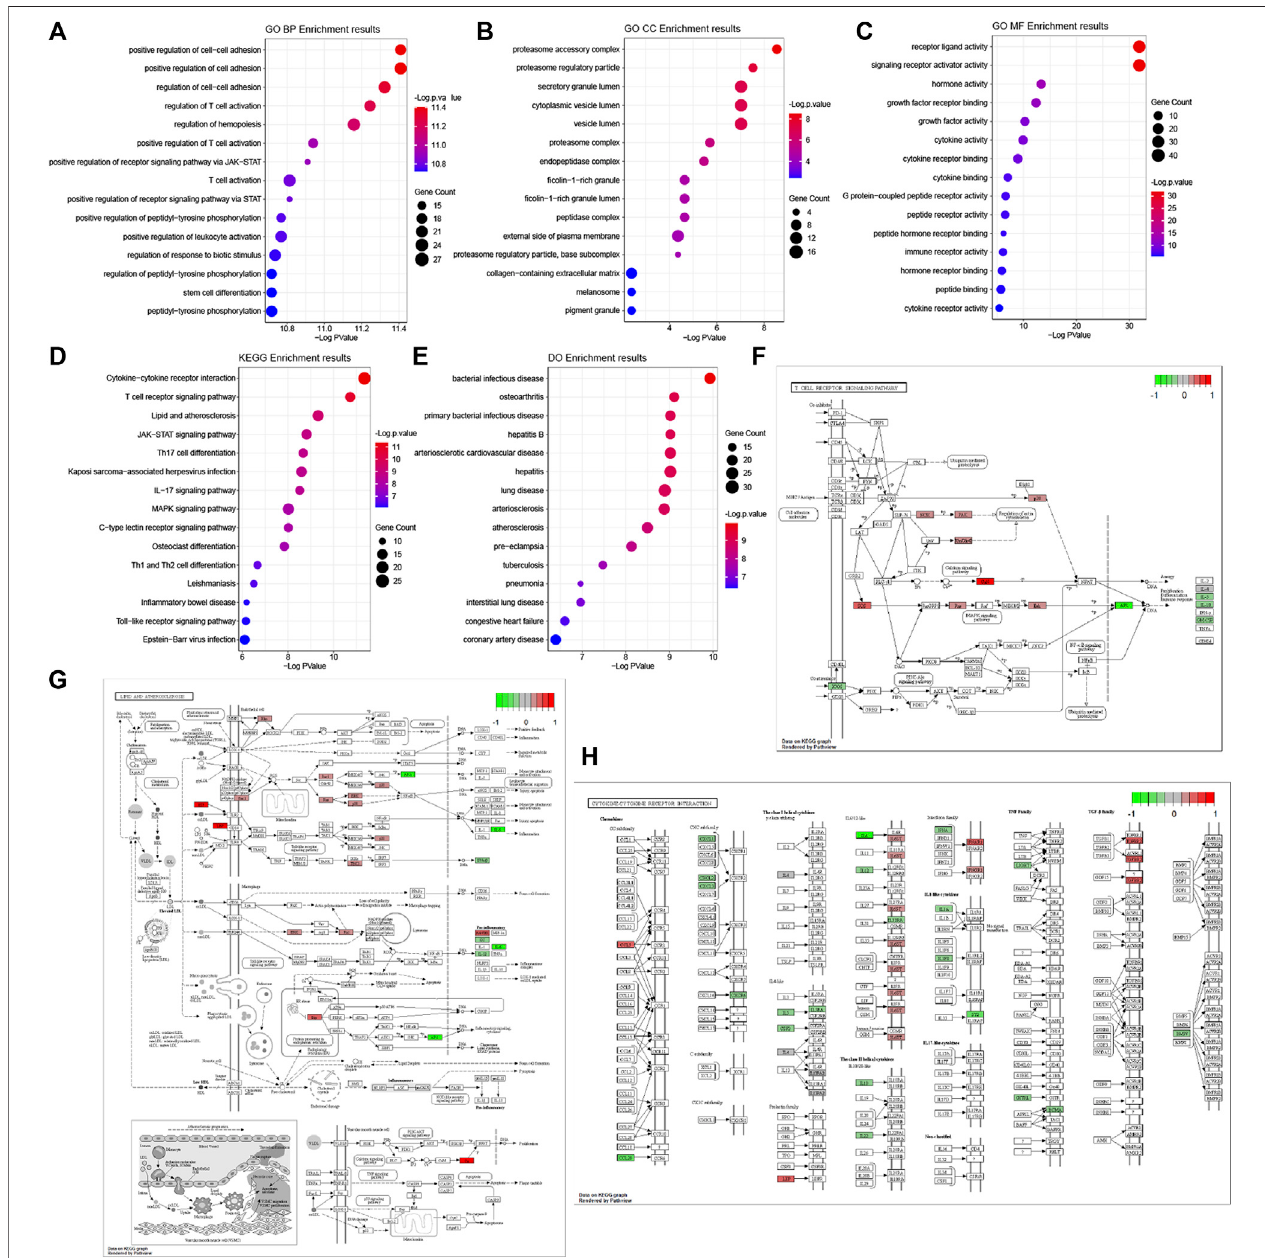
FIGURE5| GO,KEGGpathwayandDotermsenrichmentanalysisofimmune-relatedDEGs.GOtermsenrichmentanalysisoftheDEGs,includingBP (A) ,CC (B) , and MF (C) categories. (D) KEGG pathway enrichment analysis of the DEGs. (E) Do terms enrichment analysis of DEGs. The size of the symbol represents the gene counts enriched in the signaling pathway. The color indicates the degree of signi fi cance. Signaling pathways of the T cell receptor signaling pathway (F) , lipid and atherosclerosis (G) , and cytokine-cytokine receptor interaction (H) . The genes signi fi cantly up-regulated fi lled in red color and down-regulated fi lled in green color.